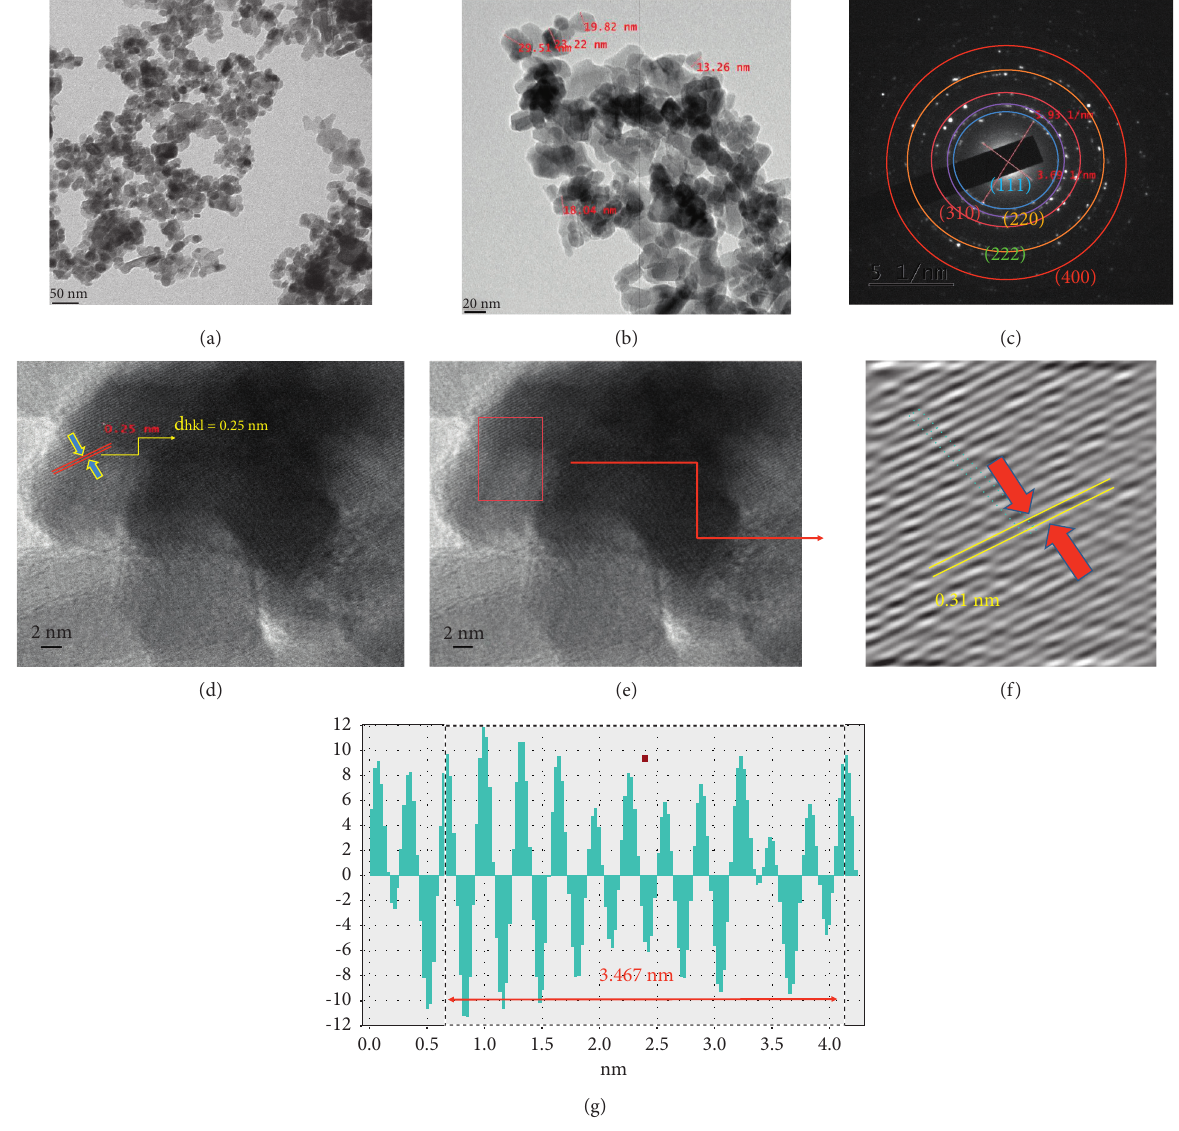
Figure 4: TEM micrograph of Co 3 O 4 (1:1) NPs at (a) 50nm and (b) 20nm magnification, (c) SAED pattern, (d) HRTEM image (1), (e) HRTEM image (2), ((f) HRTEM image (3), and (g) the magnified IFFT